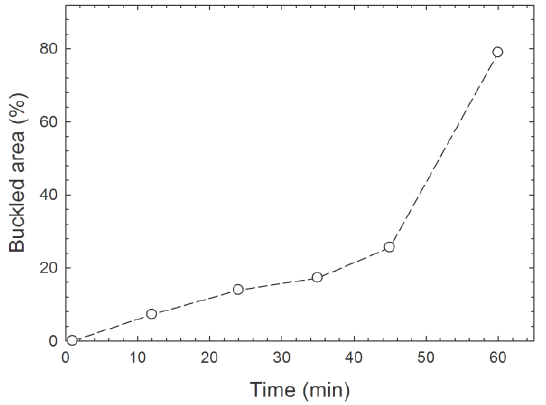
Figure 1. Photographs of deposited Cu x N film on Si substrates taken ( a ) 1 min; ( b ) 12 min; ( c ) 24 min; ( d ) 35 min; ( e ) 45 min; and ( f ) 60 min after the film was taken out of the deposition chamber and exposed to ambient air.